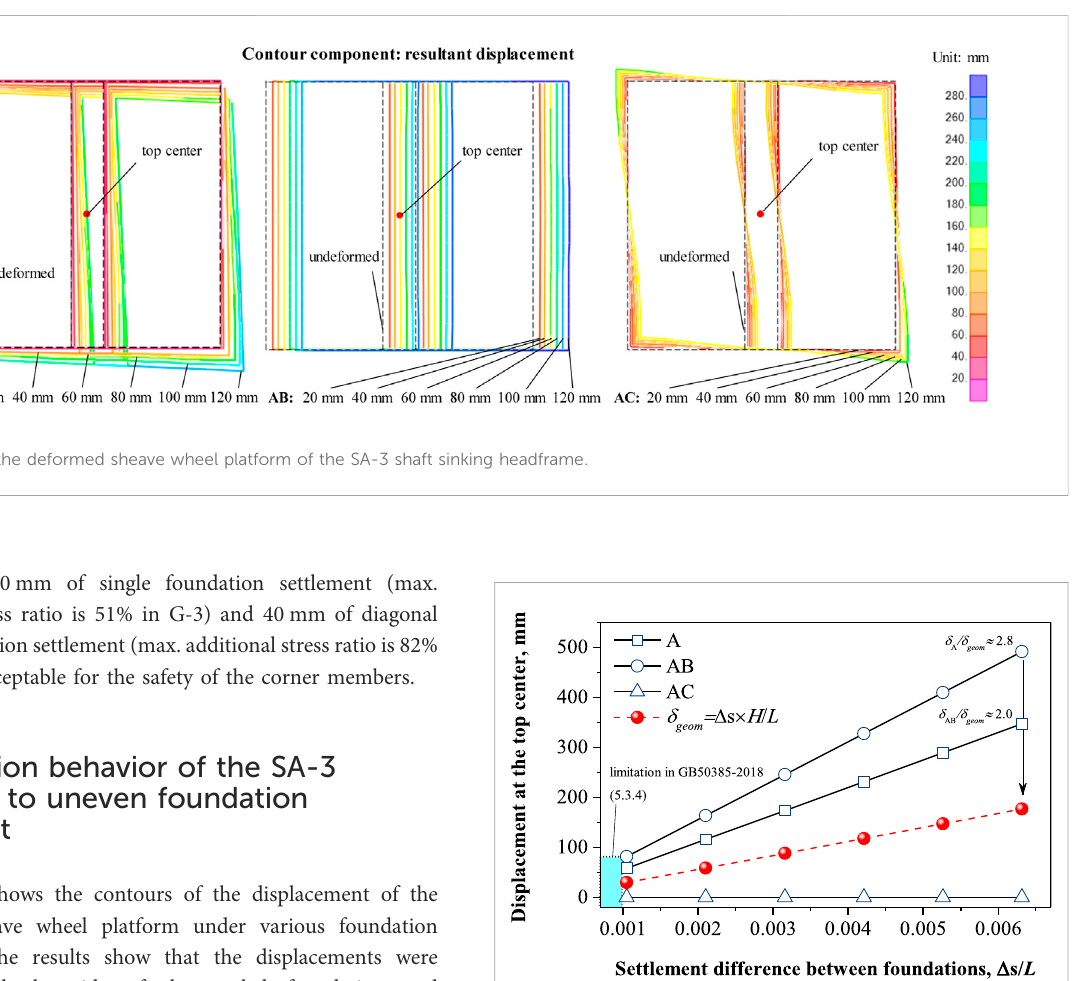
FIGURE 10 Axial force of the corner posts under uneven foundation